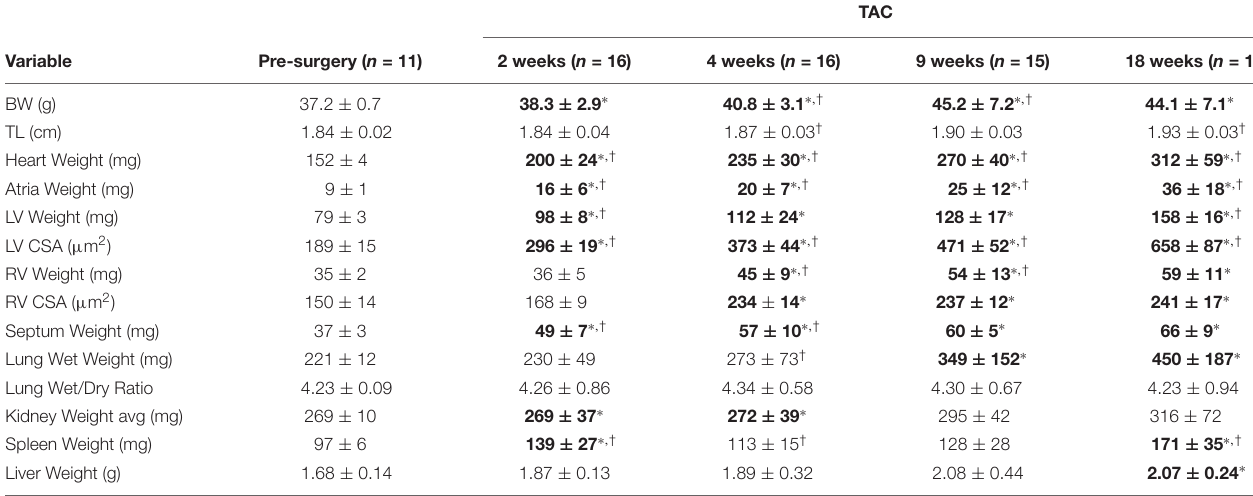
TABLE 3 | Morphometric characteristics of TAC mice.